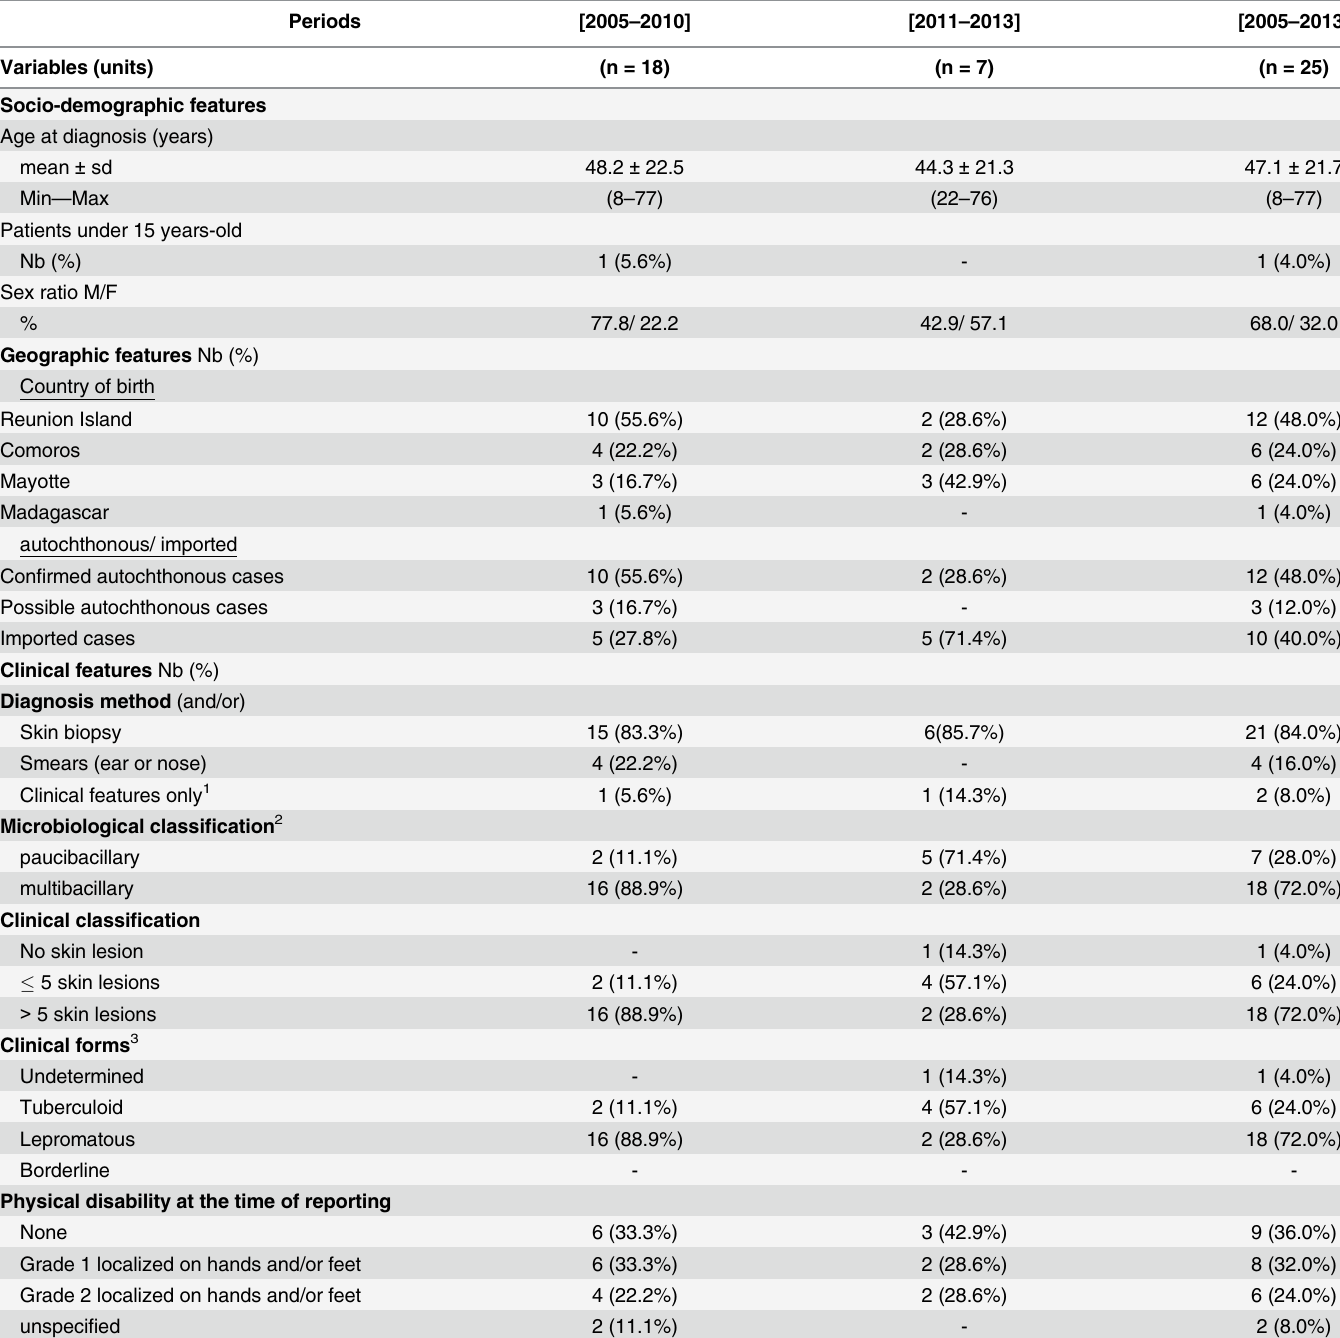
Table 1. Main characteristics of the leprosy cases identified on Reunion Island between 2005 and